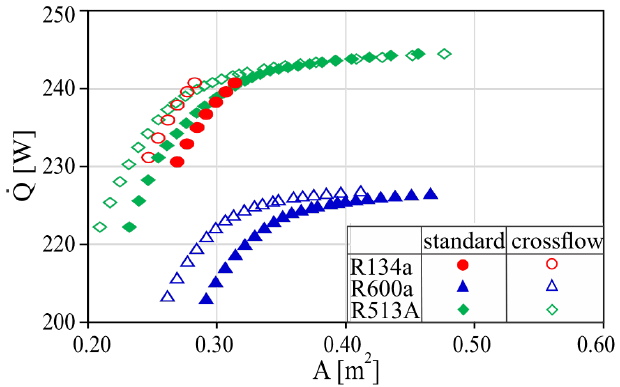
Figure 8. Heat transfers for the current and crossflow conditions.